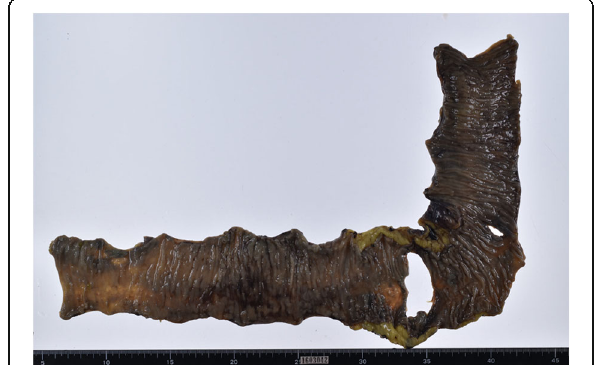
Fig. 3 Macroscopic